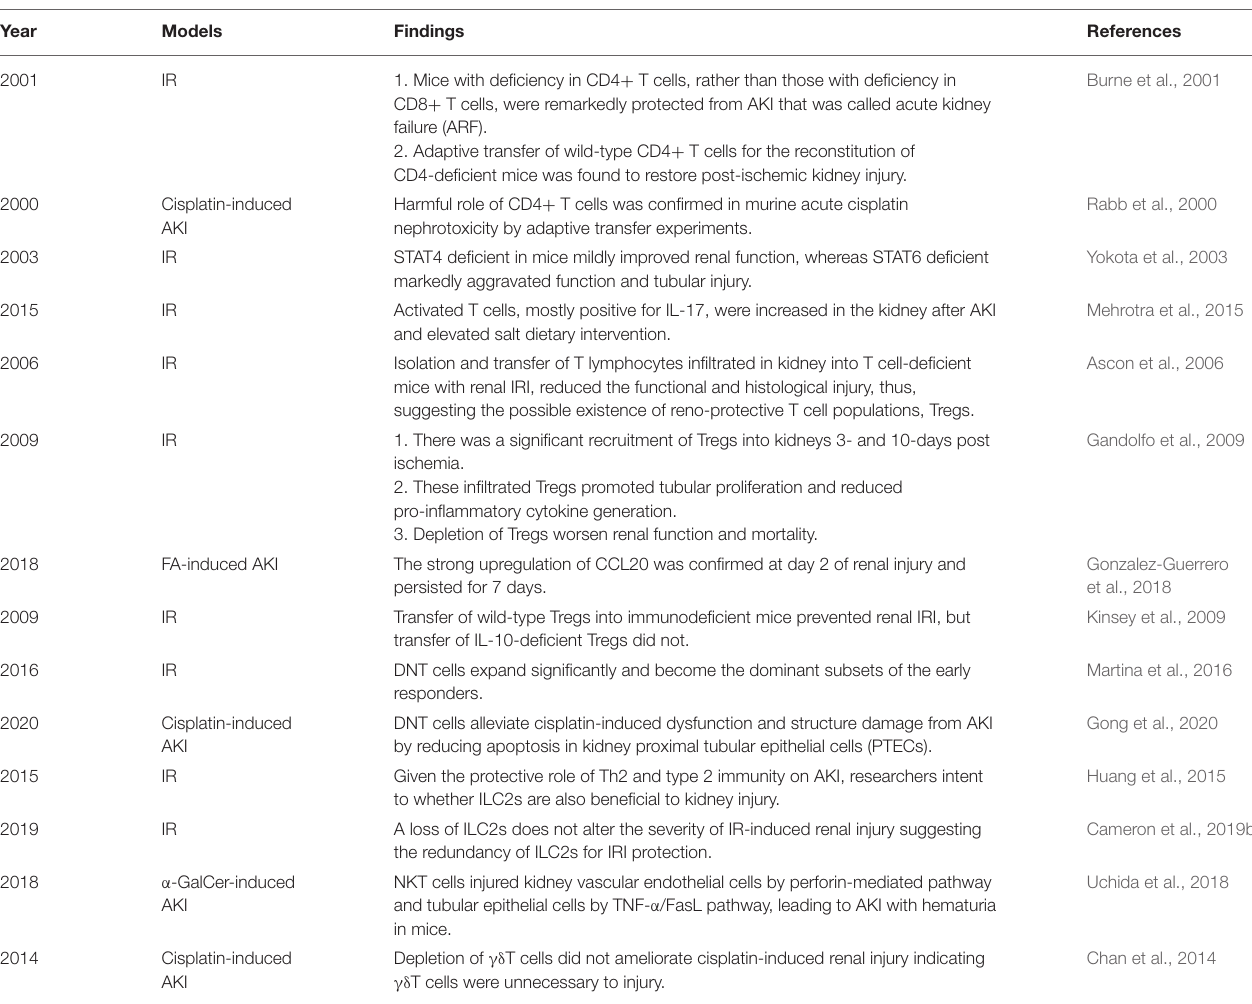
TABLE 1 | The systematically findings of lymphocytes in animal experiments of